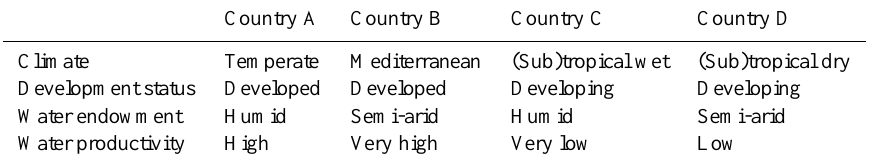
Table 3. The four countries in the Globalization of Water Role